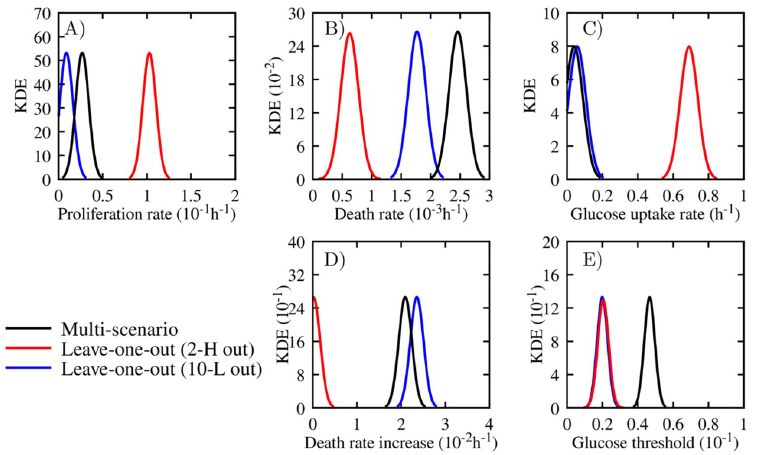
Fig 14. Posterior kernel density estimation (KDE) of the multi-scenario and the leave-one-out experiments. The KDE obtained during the calibration of the multi-scenario calibration π post ( θ | D ) (black), the high tumor initial ) (red), and the low tumor initial condition and 10 mM condition and 2 mM glucose condition left out π post ( θ | D � 2 H glucose condition left out π post ( θ | D � 10 L ) (blue) for the following parameters: � a (proliferation rate—panel A), � a P D (death rate—panel B), λ (glucose uptake rate—panel C), γ D (death rate increase—panel D), and σ H (glucose threshold —panel E). Leaving scenario 2-H out of the calibration causes a stronger shift in the parameter distributions than leaving out scenario 10-L. This indicates that 2-H is a scenario that cannot be represented adequately by the other experiments.